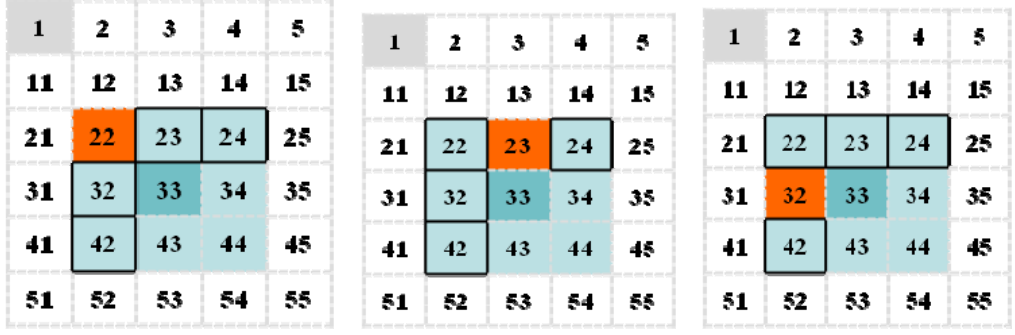
Figure 3. An example of forward zones according to victim zones (destination zone 1, victim zone is 22, 23 and 32 for each respective